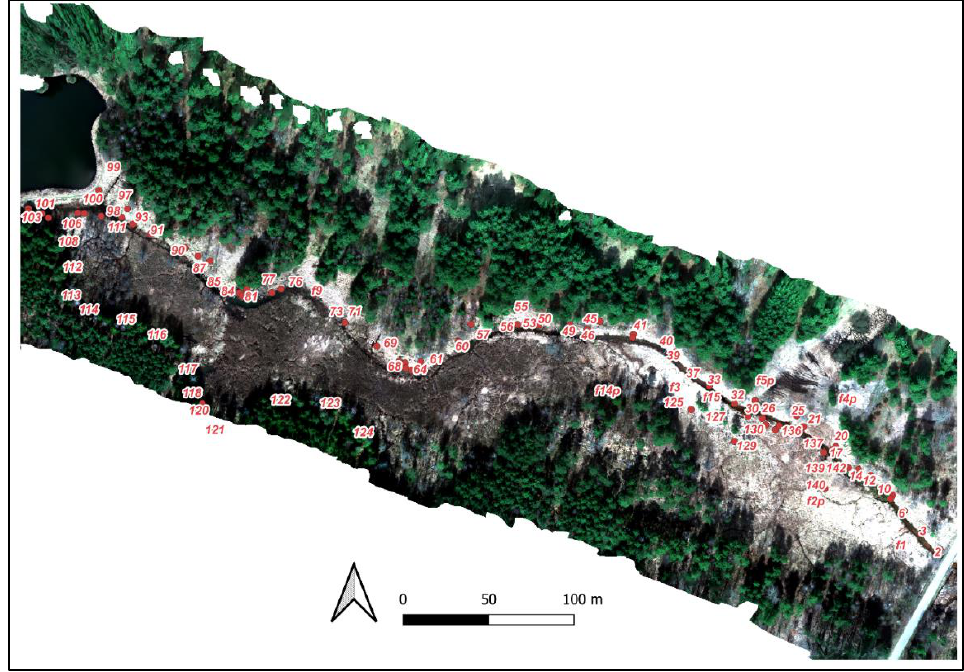
Figure 4. Points measured in the field using GNSS RTN method against orthophotomosaic; source: orthophotomosaic created by Szymon Sobura; measurement and drawing — own elaboration. orthophotomosaic created by Szymon Sobura; measurement and drawing—own